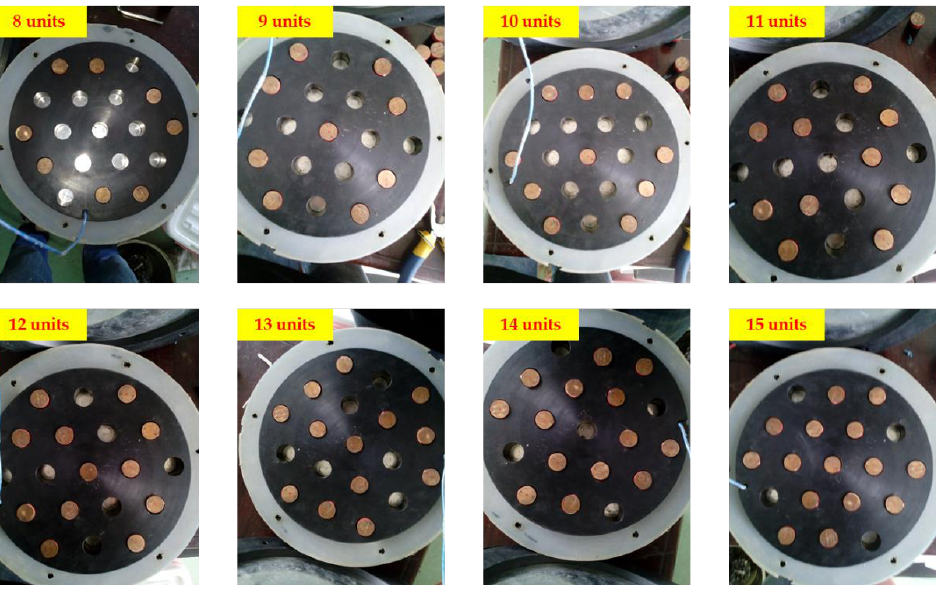
Figure 14. The number of piezoelectric units from 8 to 15.